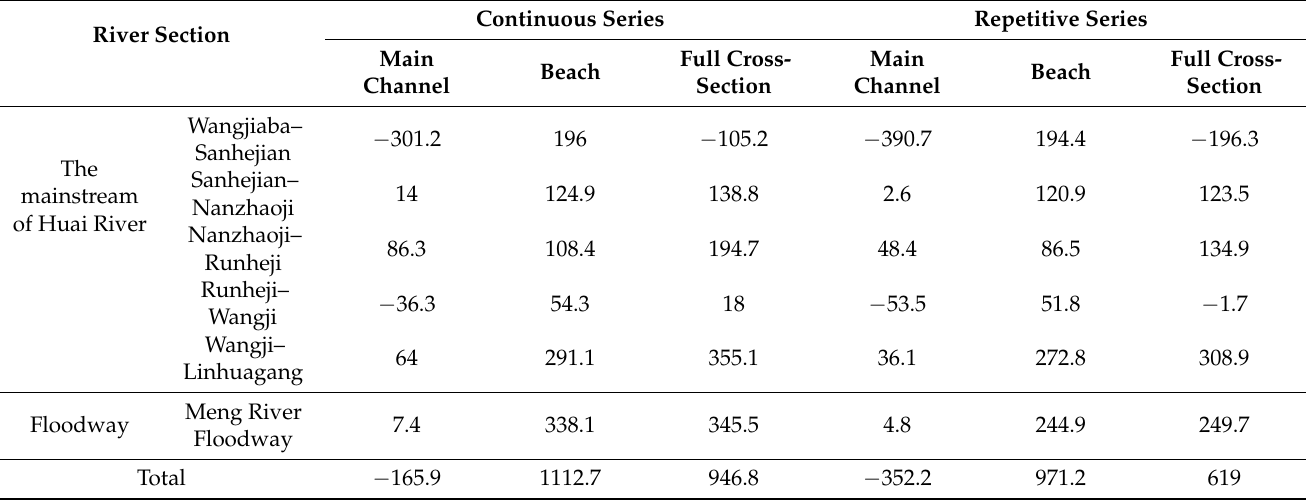
Table 5. Distribution of river erosion and deposition at the end of the simulated scenarios (unit: 10,000 m 3 ). River Section